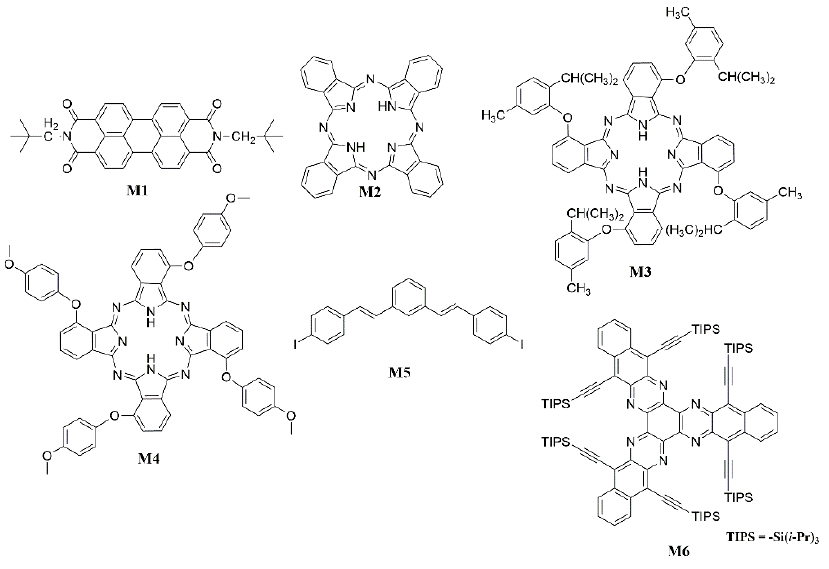
Figure 9. Chemical structures of M1 to M6 .